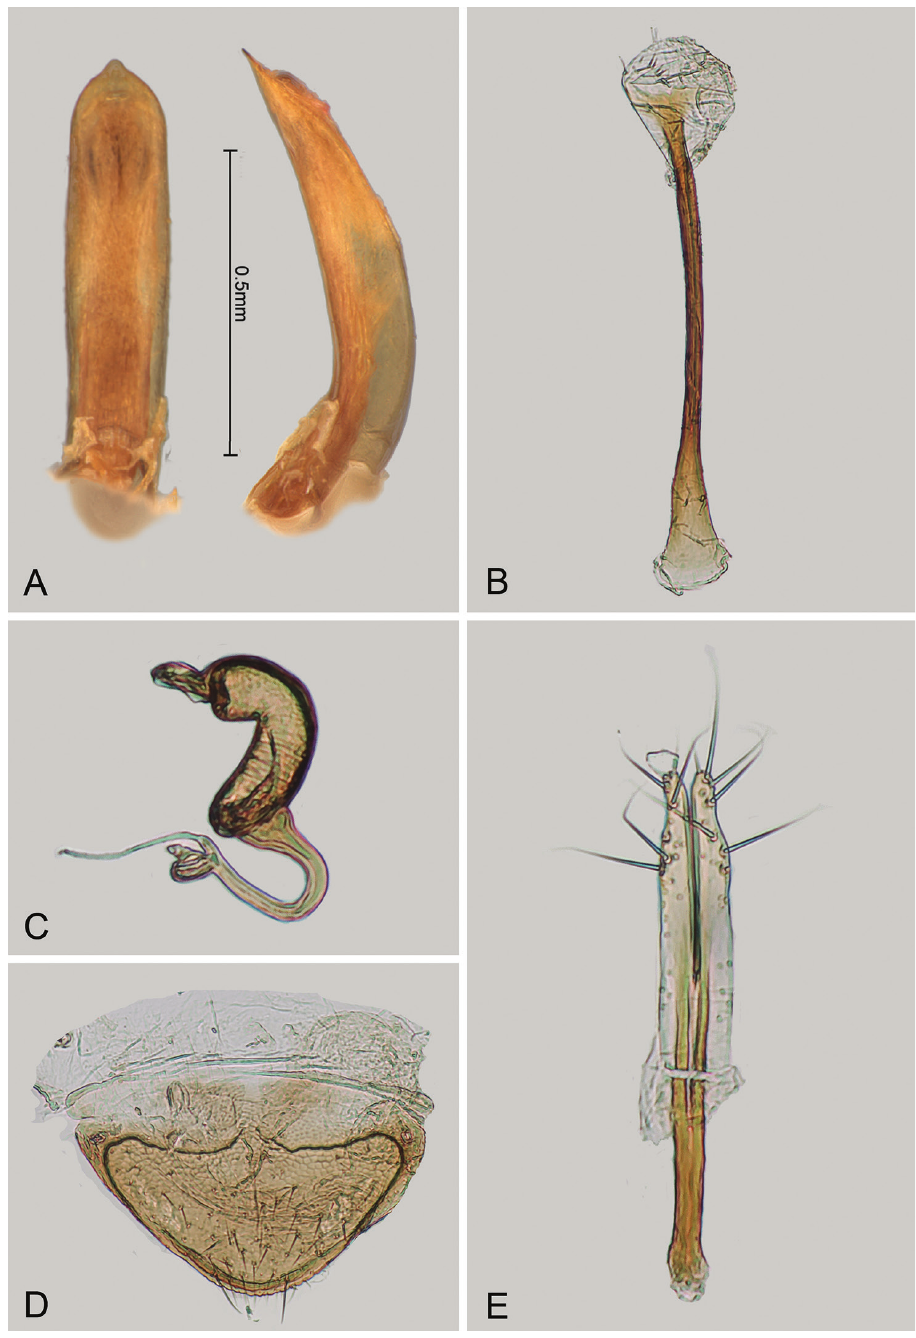
Figure 24. Andersonoplatus microoculus . A Median lobe of aedeagus, ventral and lateral views B Tignum C Spermatheca D Last abdominal tergite of female E Vaginal